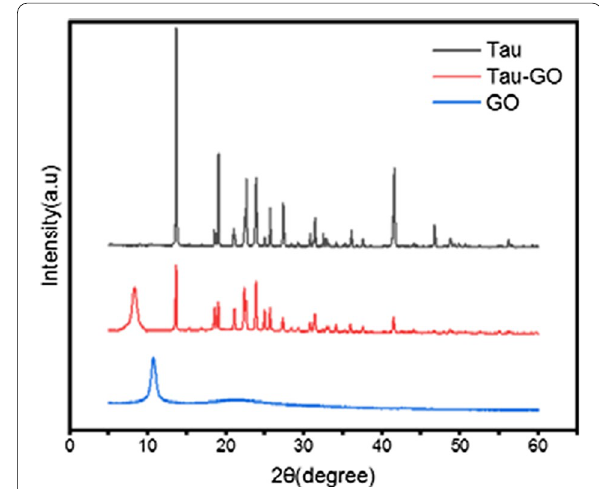
Fig. 8 XRD patterns of Tau, Tau-GO and